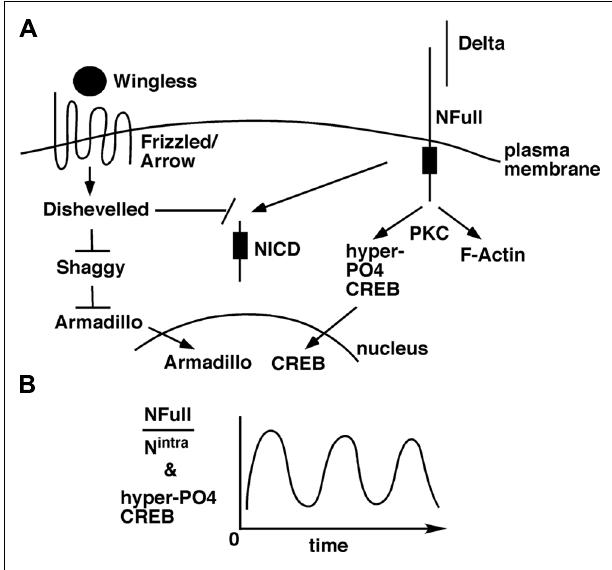
FIGURE 2 |A model for how the non-canonical NFull-PKC activity, canonical Notch signaling, andWingless/Wnt signaling might funtion during LTM formation. (A) LTM forming stimulus activates Delta and Wingless that in turn activate NFull and Dfrizzled/Arrow receptors, respectively, and result in nuclear activities of Armadillo and CREB. Wingless/Wnt signaling might also block NICD activity, which might be important for modulating the frequency of hyper-P04 CREB oscillation. (B) Ultradian oscillation of hyper-P04 CREB might be genereted by the periodic fluctuation in the ratio of NFull and NICD